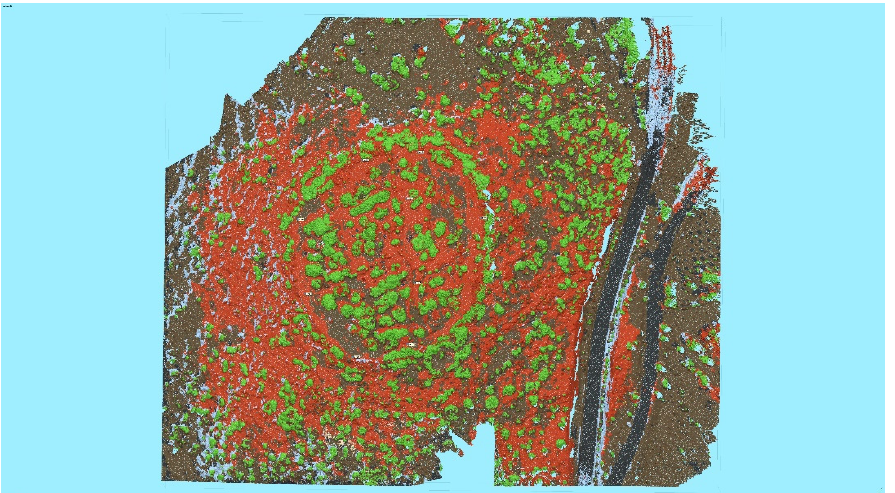
Figure 3. The dense point cloud from Kastrouli, as classified by the fully automated Classify Points algorithm. Green points are classified as “high vegetation”, orange points are classified as “building”, and brown points are classified as “ground”. Much of the bare earth at the site is incorrectly classified as “building.”